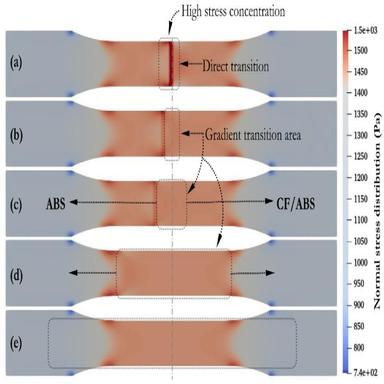
Normal stress distribution at the interface of the tensile samples, (a) direct transition from ABS to CF/ABS, (b) gradient transition within 5% of total length, (c) gradient transition within 10% of total length, (d) gradient transition within 30% of total length, (e) 100% linear transition throughout the specimen.